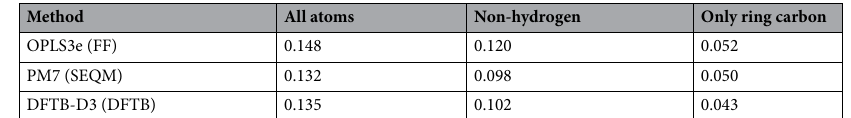
Table 1. The difference in the optimized molecular geometry using various calculation methods with reference to PBE (DFT) geometry under various atomic constraints. The average RMSD values for the 86 molecules are shown in units of Å. RMSD values have been calculated for all atoms, all non-hydrogen atoms, and carbon atoms of molecule